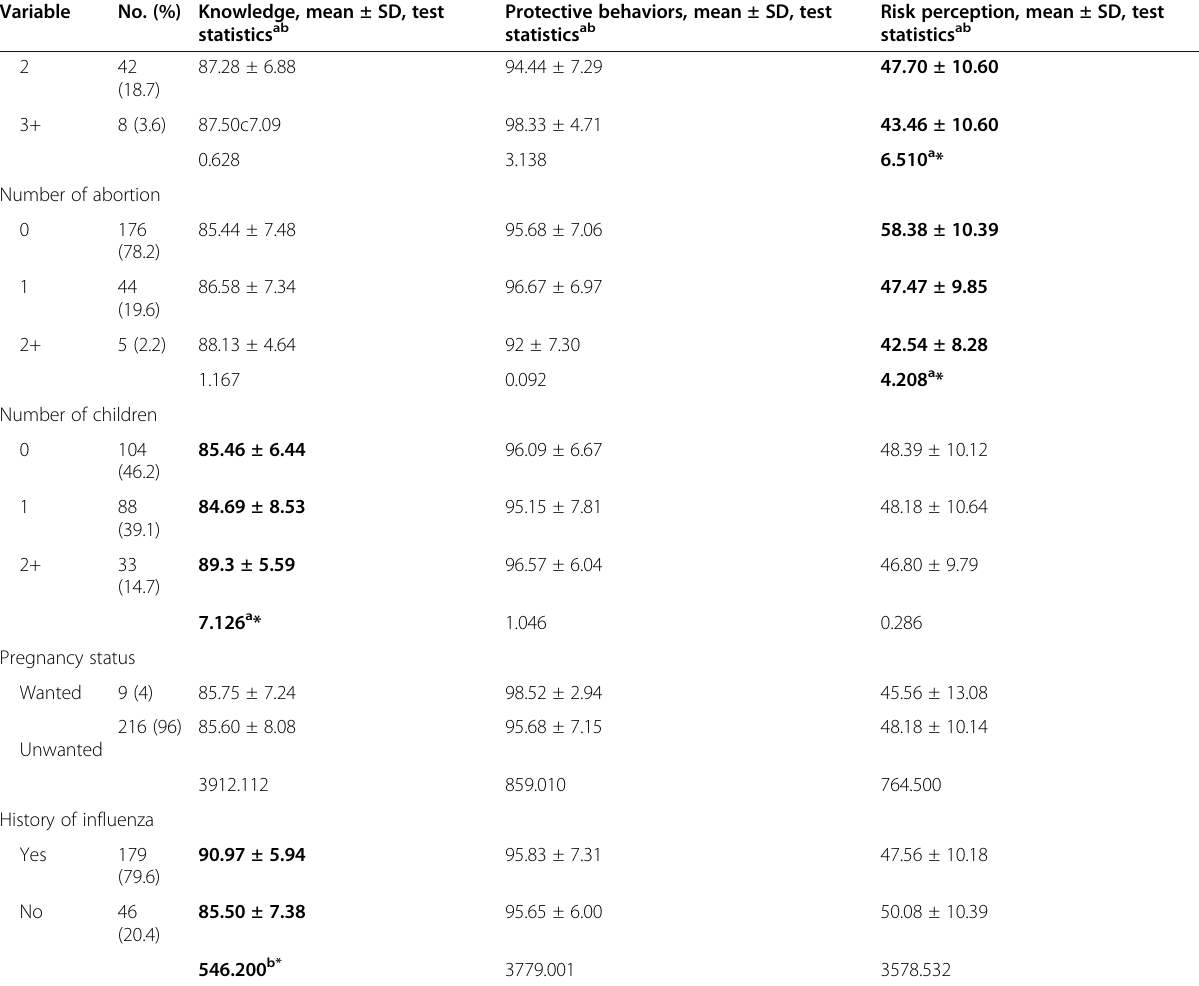
Table 3 Differences in major variables according to demographic and obstetrics characteristics (Continued) Variable